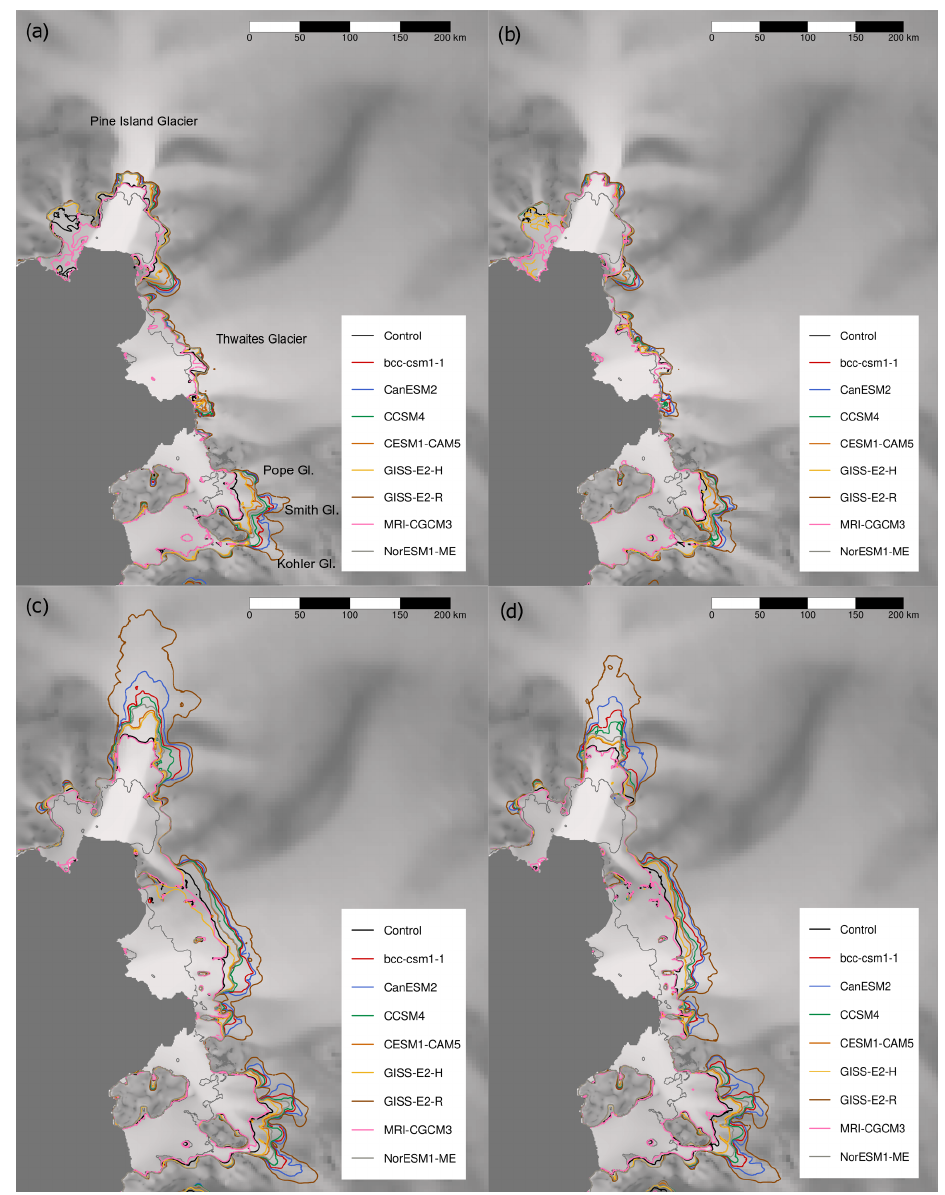
Figure 5. ASE ice stream grounding line position in 2100 in response to each CMIP5-AOGCM-projected ocean temperature forcing under RCP8.5 for each parameter set: (a) optimum, (b) low end, (c) median, (d) high end. The grey grounding line is the initial